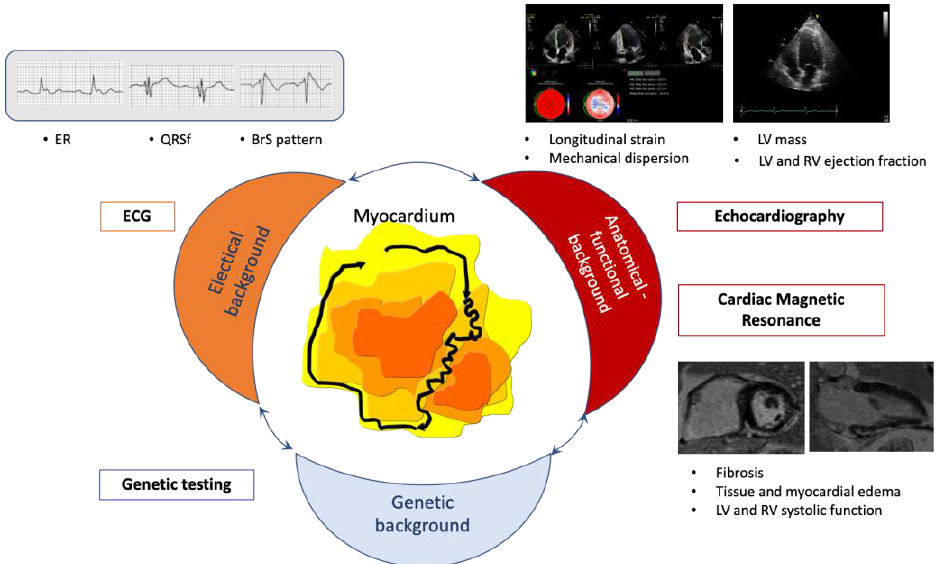
Figure 1. Figure summarizes the features related to increased risk of ventricular arrhythmias obtained by ECG, imaging (echocardiography and cardiac magnetic resonance) and genetic techniques. BrS: Brugada Syndrome; ER: early repolarization; LV: left ventricular; QRSf: fragmented QRS.